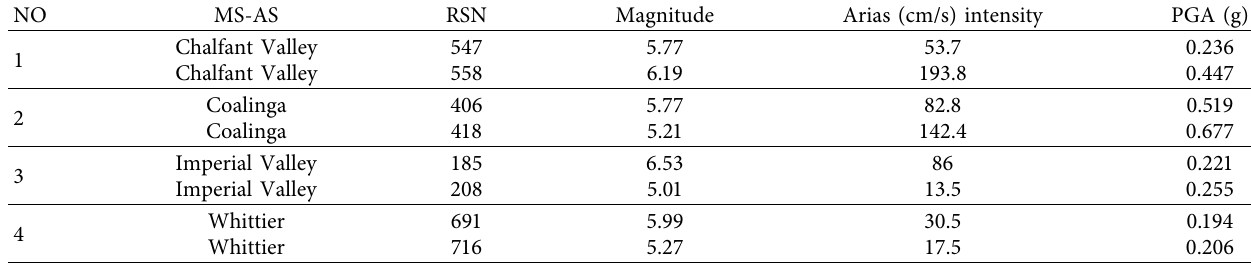
Table 12: Real seismic records with PGA (AS to MS) greater than 1.0 [16, 39].